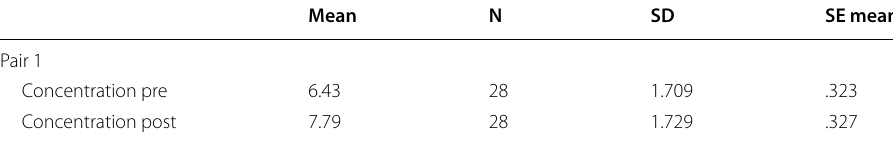
Blindfold reading/colour identification